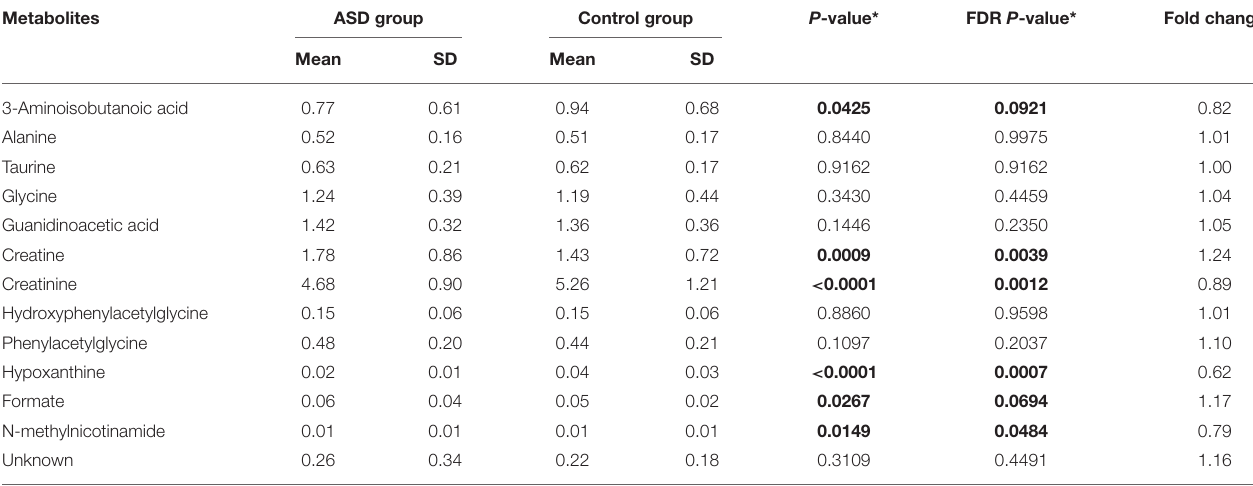
TABLE 2 | Peak areas of differential metabolites after the total area normalization.